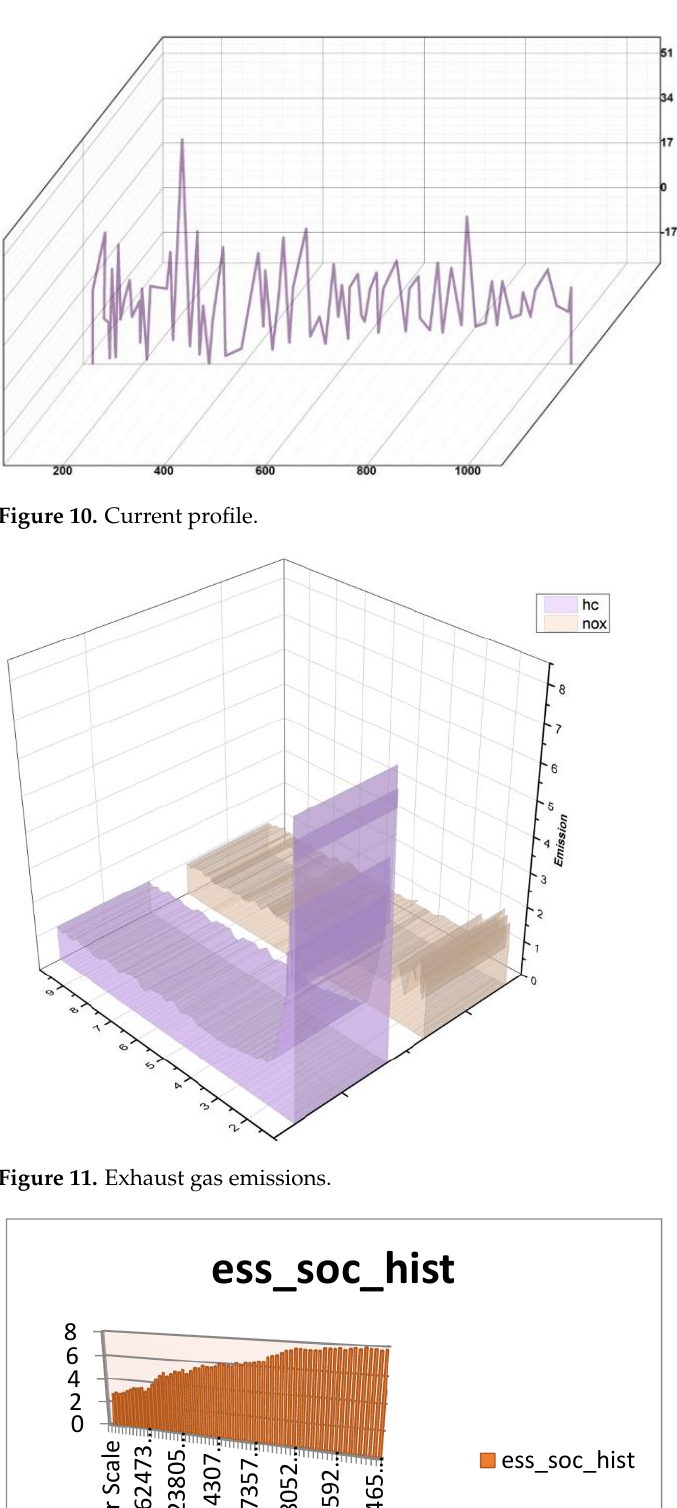
Figure 12. SOC curves.